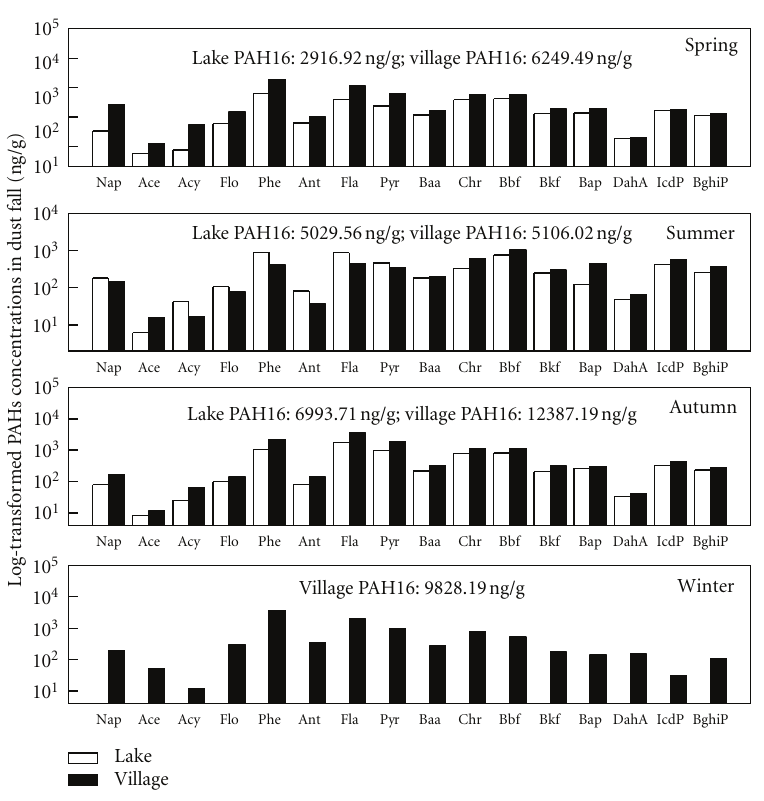
Figure 4: Seasonal-spatial variation in PAHs in the dust fall at Lake Small Baiyangdian.